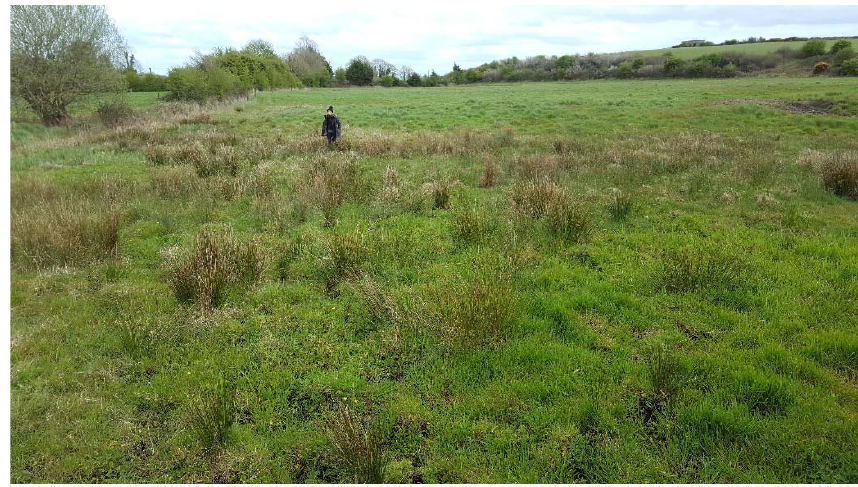
selenium values are in a zone in the centre of the field (Figure 2).